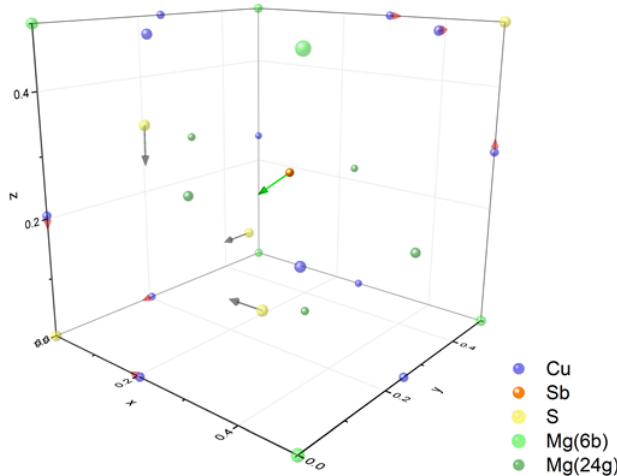
Figure 9. Example plot of atomic position shifts (arrows show 10 × multiplied atomic position shift) for Mg 0.5 Cu 12 Sb 4 S 13 sample (pure Cu 12 Sb 4 S 13 sample is used as a reference).